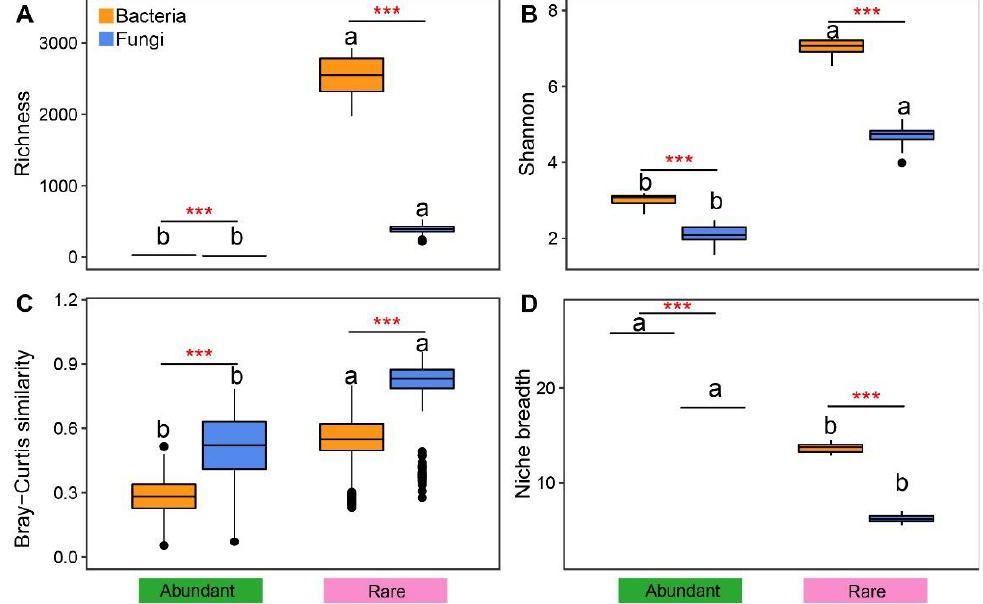
Figure 1. Variations in diversity and niche breadth of abundant and rare rhizosphere bacteria and fungi in broomcorn millet field. ( A ) Richness box plot; ( B ) Shannon box plot; ( C ) Bray–Curtis dissimilarity box plot; ( D ) niche breadth box plot. Different letters above bars and *** indicate significant differences ( p < 0.05, and <0.001) according to the nonparametric Mann–Whitney U test.